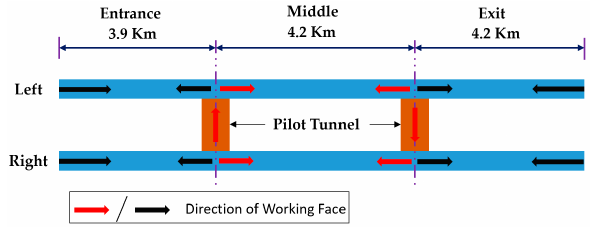
Figure 8. Schematic diagram of the tunneling construction scheme.